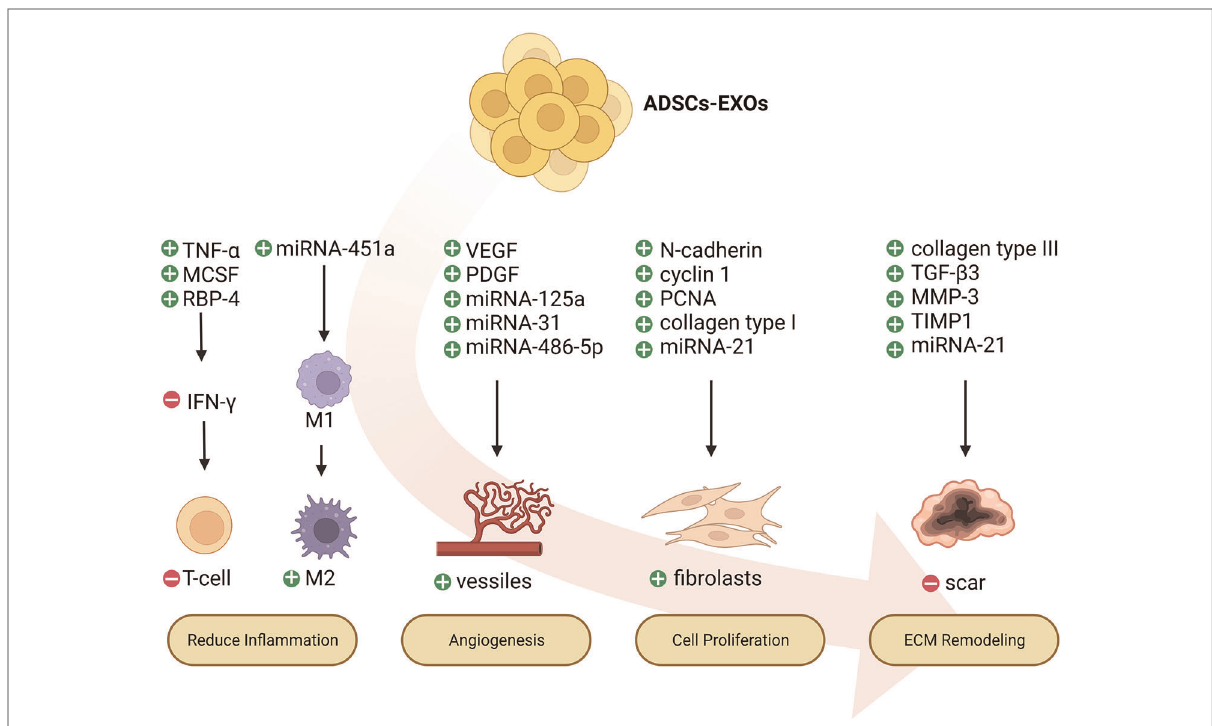
FIGURE 4 Potential mechanisms of ADSCs-EXOs regulating wound healing. ADSCs-EXOs might accelerate chronic wound repair by up-regulating early in fl ammation, promoting angiogenesis, enhancing proliferation, and regulating extracellular matrix (ECM)